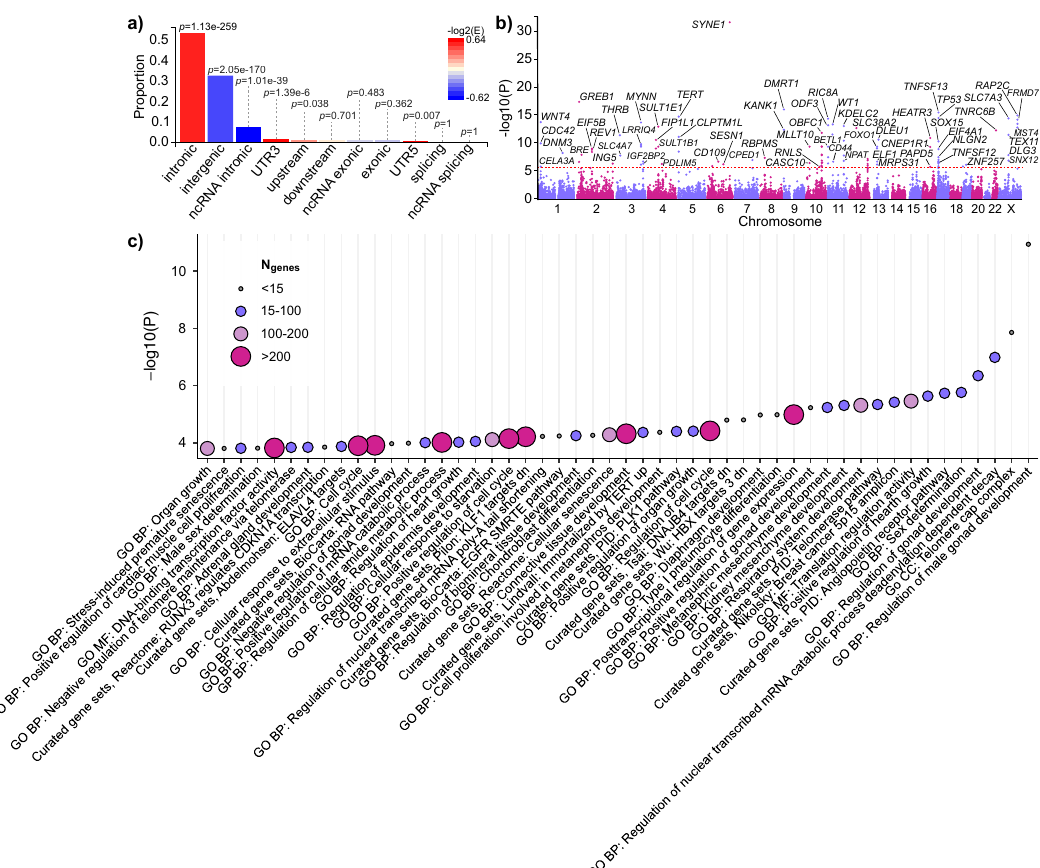
Fig. 3 | Variant summary and gene set-based results using genome-wide sum- protein-codinggenesand,thus,signi fi cancewasconsideredat p <2.51×10 − 6 (0.05/ mary statistics from META-2. a The proportions of ‘ independent genome-wide 19,920). Purple and pink colours indicate odd and even chromosome numbers, signi fi cantvariants ’ and ‘ variantsinLDwithindependentsigni fi cantvariants ’ having respectively. Thirty-seven gene symbols are omitted. c MAGMA 51 gene-set enrich- ment analysis was performed for curated gene sets and GO terms available at corresponding functional annotation. Bars are coloured according to P values are − log MsigDB 52 . The plot shows the results for signi fi cantly enriched pathways 2 (enrichment) relative to all variants in the reference panel. obtained using Fisher ’ s exact test (two-sided). b A Manhattan plot of the gene- ( p FDR <0.05). All data plotted in Fig. 3a – c were produced using FUMA 49 based test computed by MAGMA 51 . The input variants were mapped to 19,920 p ‘ metanephricmesenchymedevelopment ’ , p FDR =0.0063; FDR =0.0065; ‘